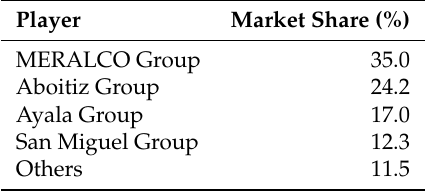
Table 3. Retailers’ market share in the Philippines based on the number of contestable customers